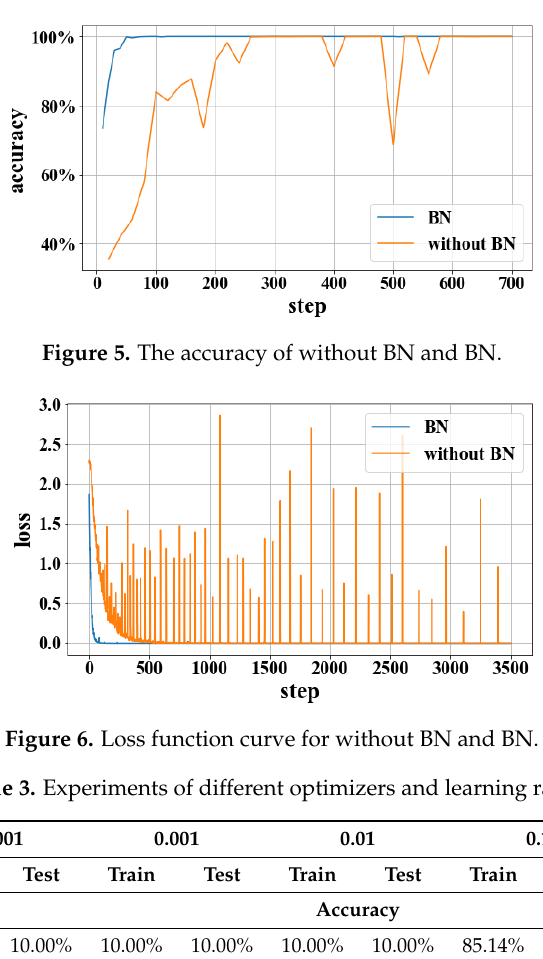
Table 3. Experiments of different optimizers and learning rates.